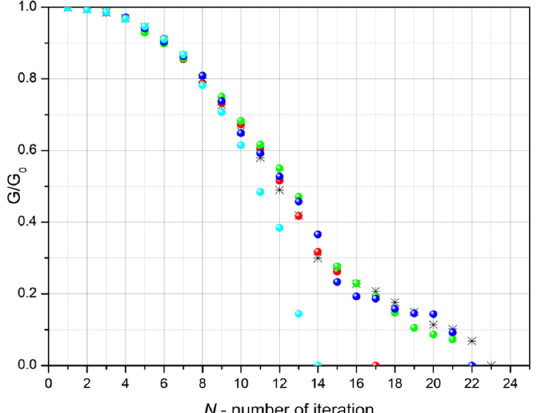
Figure 6. The conductivity ratio of the conductive layer with defects to the layer without defects calculated in successive iteration steps for various random realizations (various colors) of defects = σ ( d 0 = 0.2, σ d = 0.04,  52 ). ( d = 25 ◦ ). α 0 = 0.2, σ d = 0.04, σ α